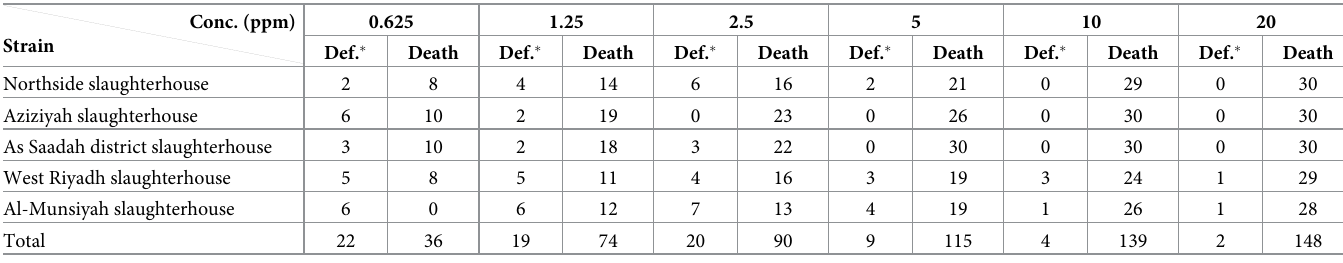
Table 3. Number of deformity cases induced by pyriproxyfen at each concentration. Conc. (ppm)